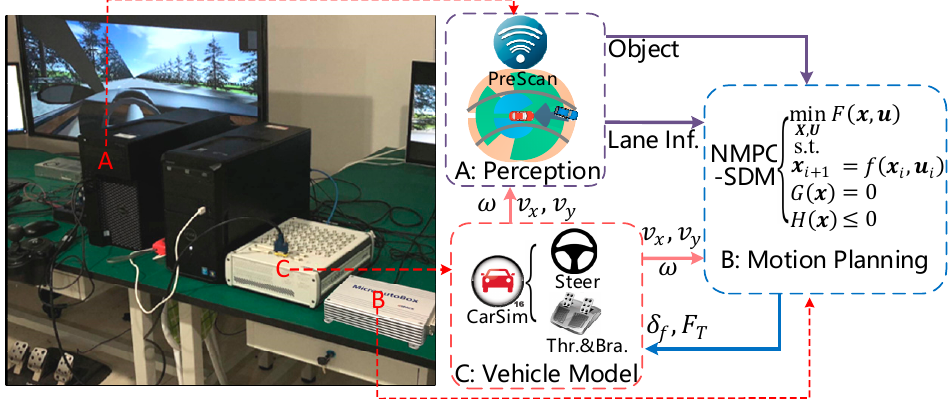
Figure 7. Block diagram of the hardware-in-the-loop (HIL).